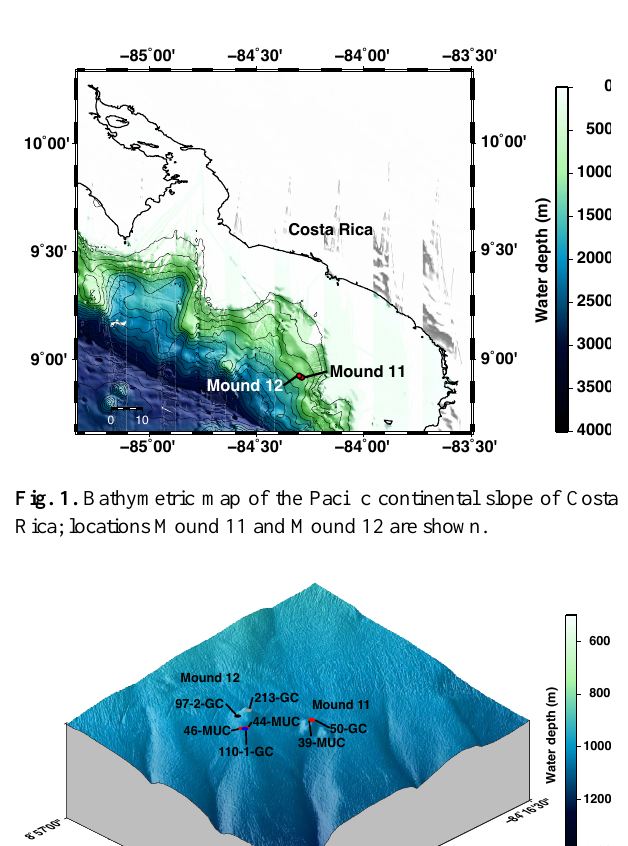
to constrain the hydrological conditions during the precipita- tion, the equilibrium δ 18 O values for the different carbonate phases with water were calculated for present local seafloor conditions, i.e. a bottom-water temperature of 8 ◦ C (derived from measurements during SO206) and δ 18 O of + 0.2 ‰ (SO206-39 (MUC) bottom water). The equilibrium fraction- ation factor for 18 O between calcite and water was calculated according to Kim and O’Neil (1997):